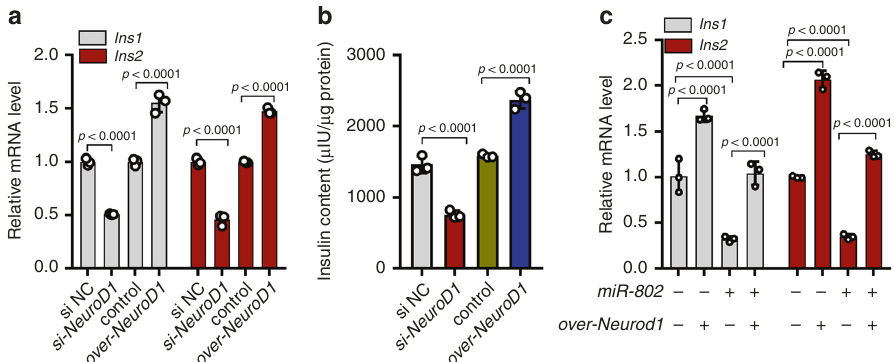
Fig. 7 miR-802 affects insulin transcription by targeting NeuroD1 . Overexpression and knockdown of NeuroD1 was conducted in Min6 cells for 48 h. Then, qRT-PCR was performed to analyze the expression levels of Ins1 and Ins2 ( a ) and insulin content ( b ). c miR-802 -induced decrease in Ins1 and Ins2 levels was partly restored by NeuroD1 overexpression. All experiments above were performed in triplicates, and each group contained three batches of individual samples. The p -values by one-way ANOVA b or two-way ANOVA a and c are indicated. Data represent the mean ± SD. Source data are provided as